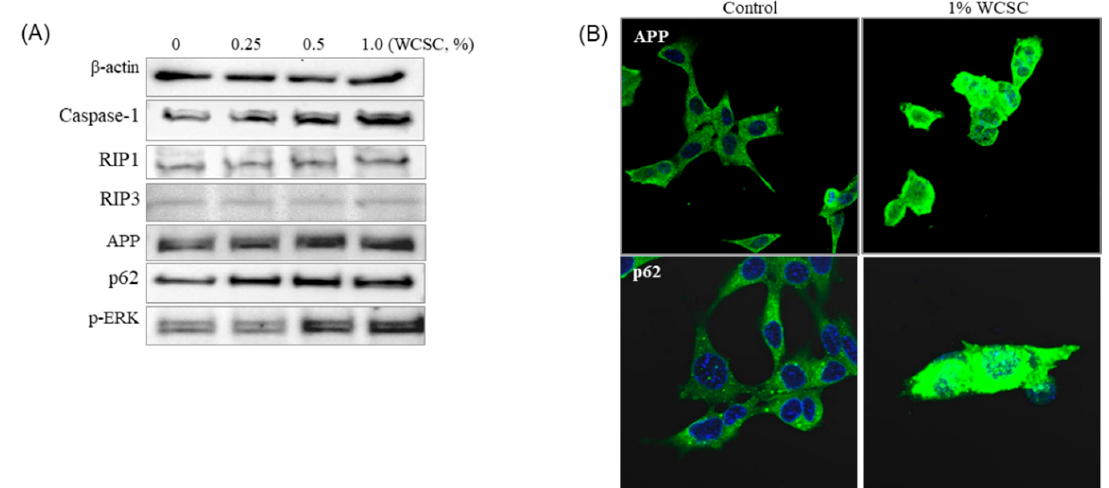
Figure 8. Effects on protein expression: ( A ) quantitative analysis of protein expression. Expression of all the proteins was independently tested three times, and they showed a similar trend; ( B ) visualization of the expressed protein. A p62 protein not only increased in the expression level but also seemed to be aggregated. Magnification: ×400.